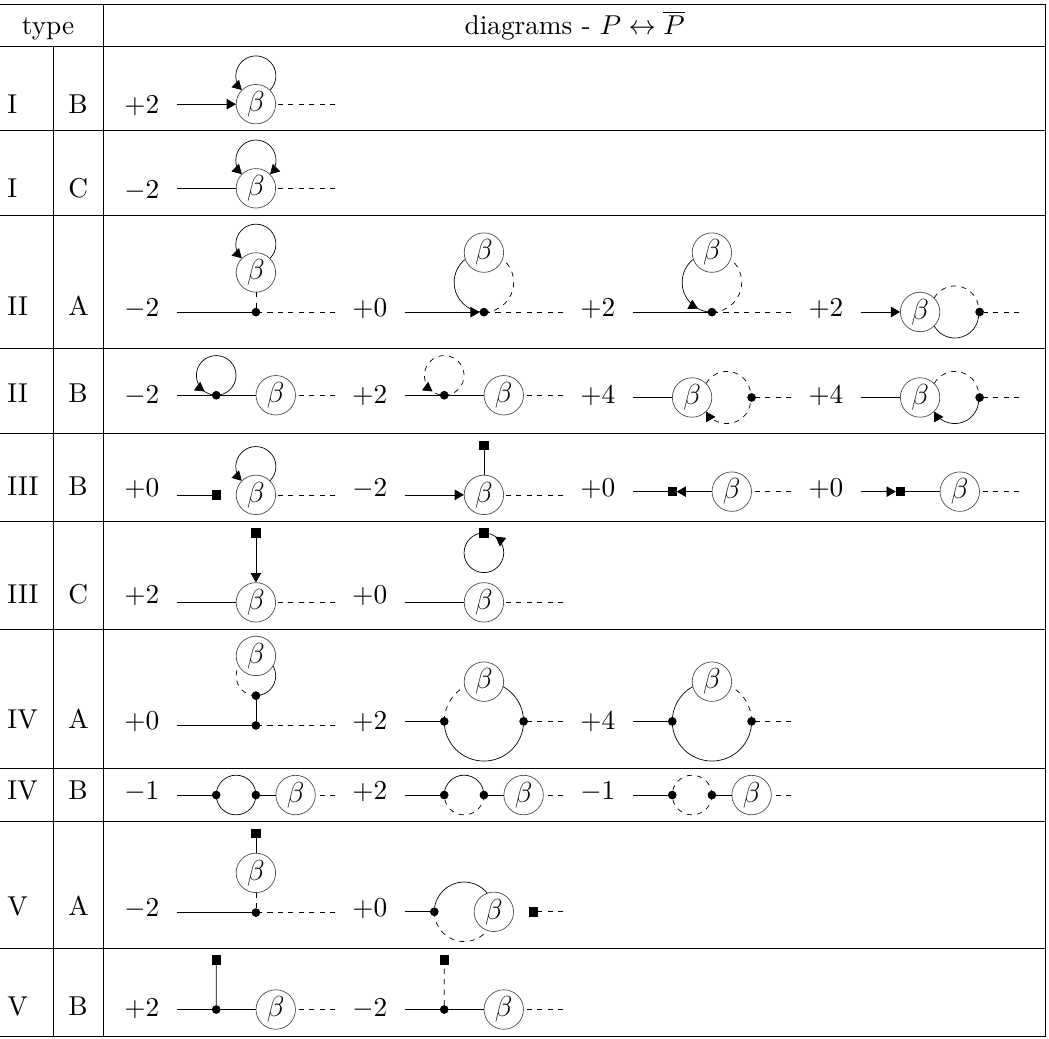
Table 2 . Diagrams which might contribute to the doubling of b K (1) and their respective coefficients. The equivalent tensor expression is given in